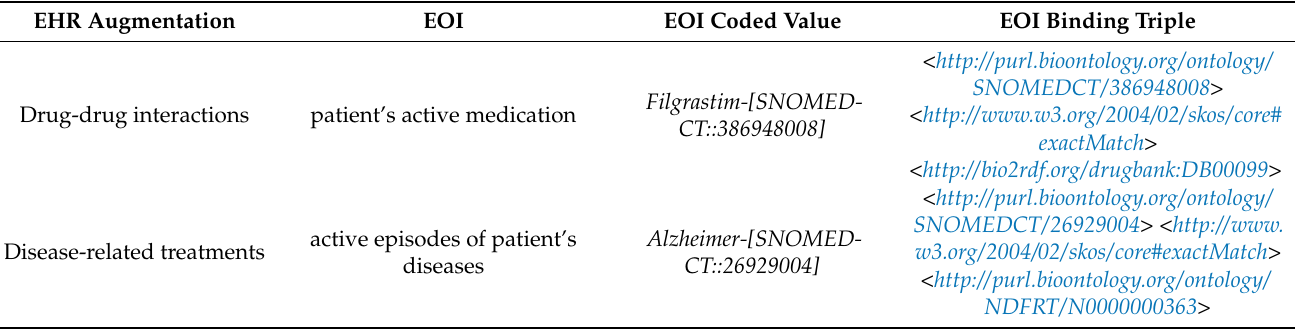
Table 3. EOI binding triples generated for each EHR augmentation taking the initial EHR extract introduced in Figure 10 and the arguments described in Tables 1 and 2,